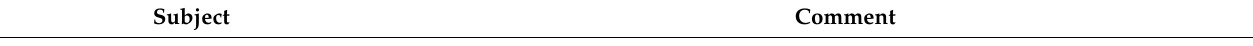
Table 2. Summary of the GHP method with a focus on glazing